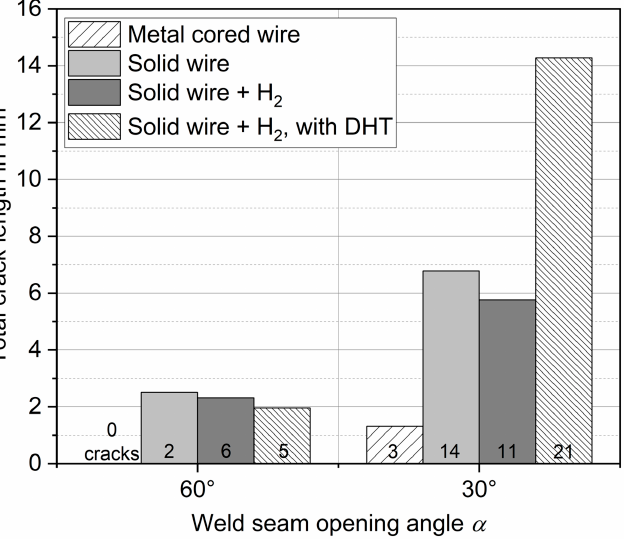
Figure 9. Total crack length and number of micro- and macro-cracks in the weld metal for different filler materials and weld configurations.